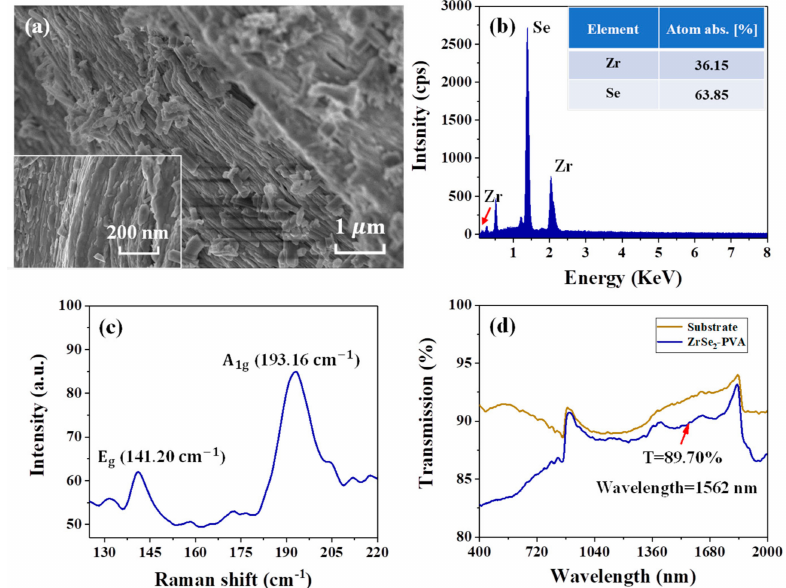
Figure 2. ( a ) Scanning electron microscopy (SEM) image of the ZrSe 2 nanocrystals (NCs) at a resolution of 1 µ m. Inset shows the SEM image at a resolution of 200 nm. ( b ) Energy dispersive